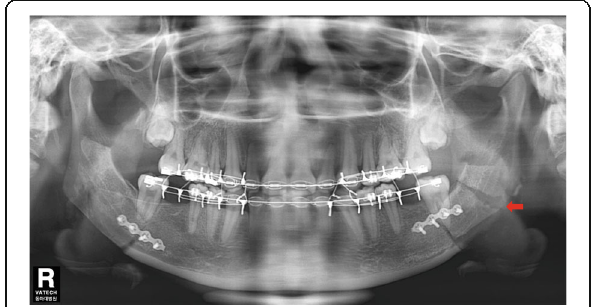
Fig. 3 Postoperative panorama of a patient who underwent additional DSO in the left distal